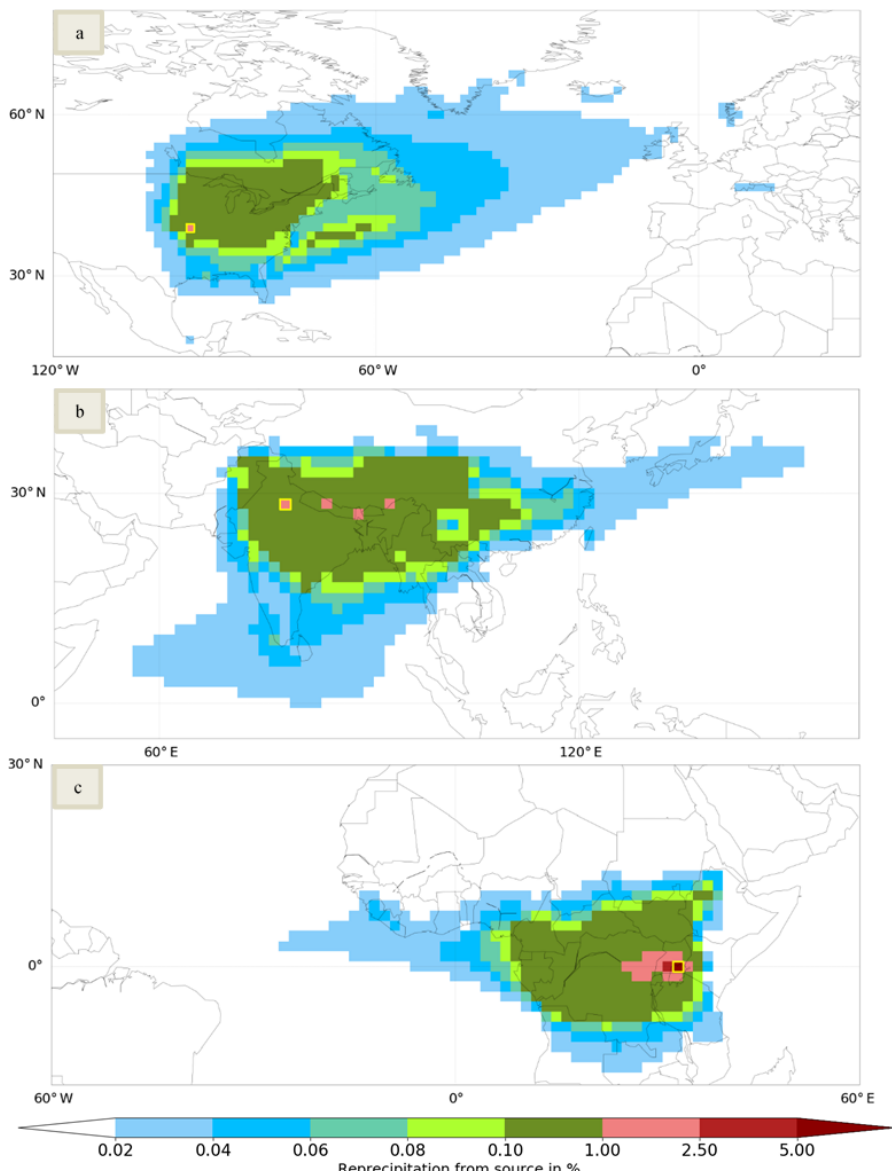
Figure 1. Examples for yearly evaporationsheds of grid cells. (a) Cell at 39.0 ◦ N latitude and 94.5 ◦ W longitude (Kansas City, US; E input : 871.6mma − 1 ; unassigned: 2.3%); the colored area covers 70.0% of the assigned water. (b) Cell at 28.5 ◦ N latitude and 78.0 ◦ E longitude (Delhi, India; E input : 1132.7mma − 1 ; unassigned: 0.1%); the colored area covers 79.0% of the assigned water. (c) Cell at 0.0 ◦ latitude and 33.0 ◦ E longitude (Kampala, Uganda; E input : 1145.1mma − 1 ; unassigned: 0.0%); the colored area covers 88.8% of the assigned